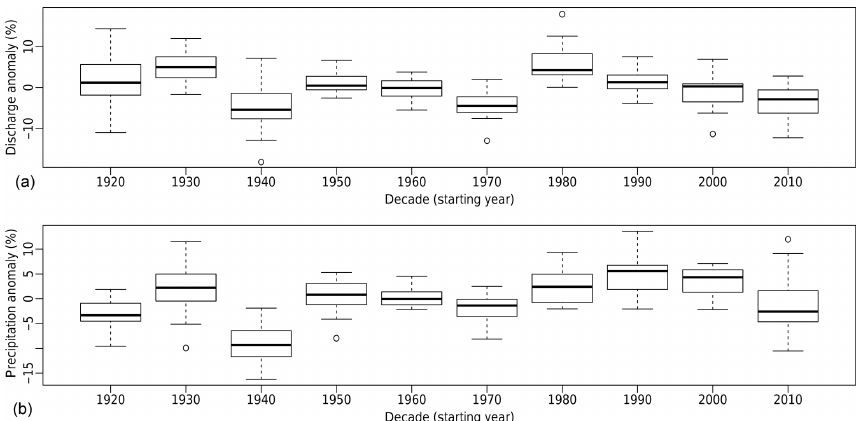
Figure 4. Relative discharge (a) and precipitation (b) decadal means of anomalies with respect to the 1920–2018 average for 20 catchments and 17 MeteoSwiss homogeneous stations with data available since 1920 (see Tables 1 and S2).